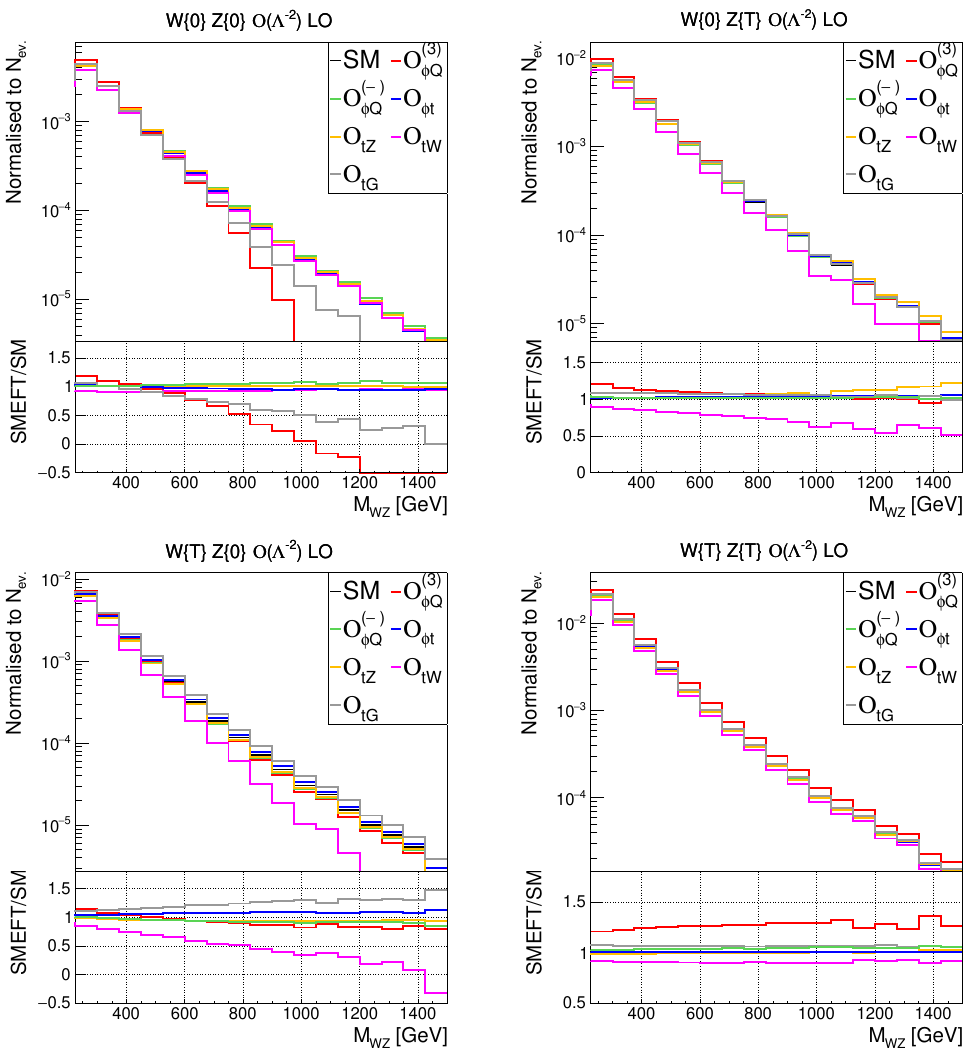
Figure 6 . Leading order SM and SMEFT contributions to the differential cross-section of the tWZ process in the WZ invariant mass for different W and Z helicity configurations. SMEFT predictions are given for c i / Λ 2 = 1 TeV − 2 , and truncated at interference-level ( O (Λ − 2 ) ). The curly brackets indicate the helicity eigenstates following the MadGraph5_aMC@NLO notation where {0} and {T} refer to longitudinal and transverse polarisations, respectively. The inset shows the ratio of the SM+SMEFT contribution to the SM